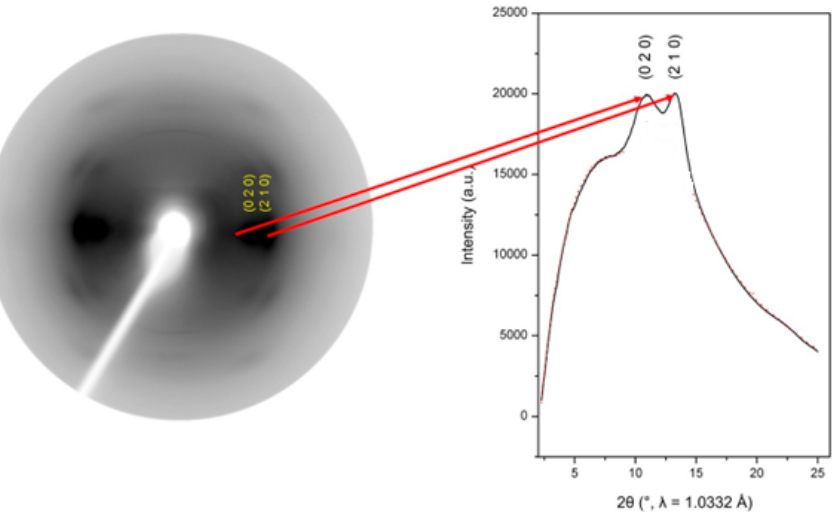
Figure 4. In spider silk, the intensity of the scattering at the (020) and (210) Bragg diffraction peaks are measured and plotted against the angle of scattering (2 θ ). It is the peaks in the curve and their widths that can be used to estimate the intensity peaks ( I x ) at specific, the full width and half width maximum intensities (FWHM) of the diffraction peaks, and the distance of greatest scattered intensity ( d ), from which further estimates of the size, density, and orientation of the crystalline β –sheets can be deduced. Image redrawn from reference [63].